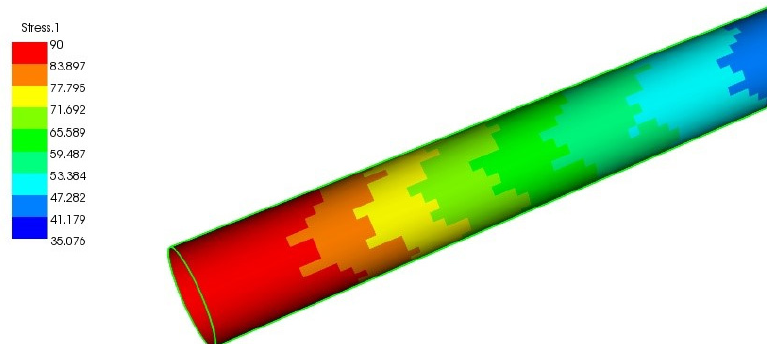
Figure 12. The stress of 30° fiber under 1.5 deg/m twist.